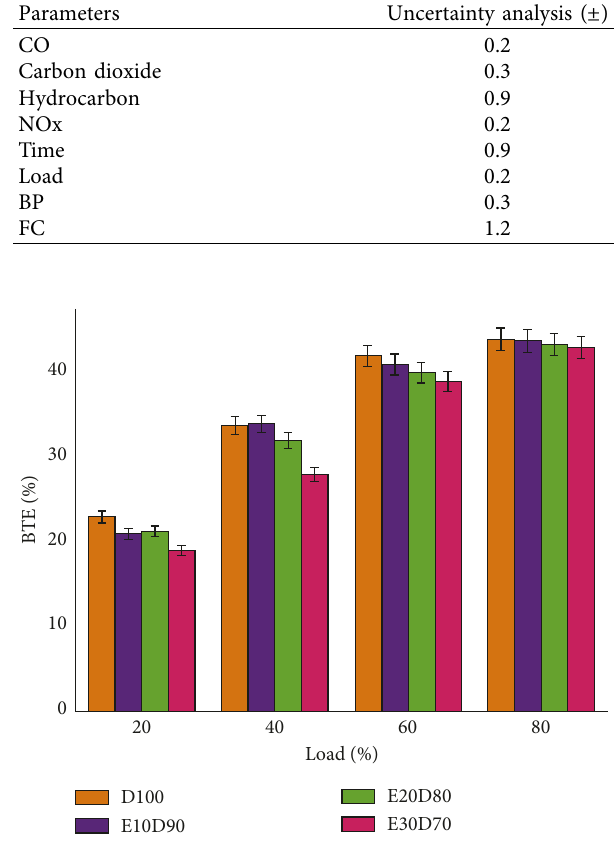
Figure 3: Variation in BTE with load.